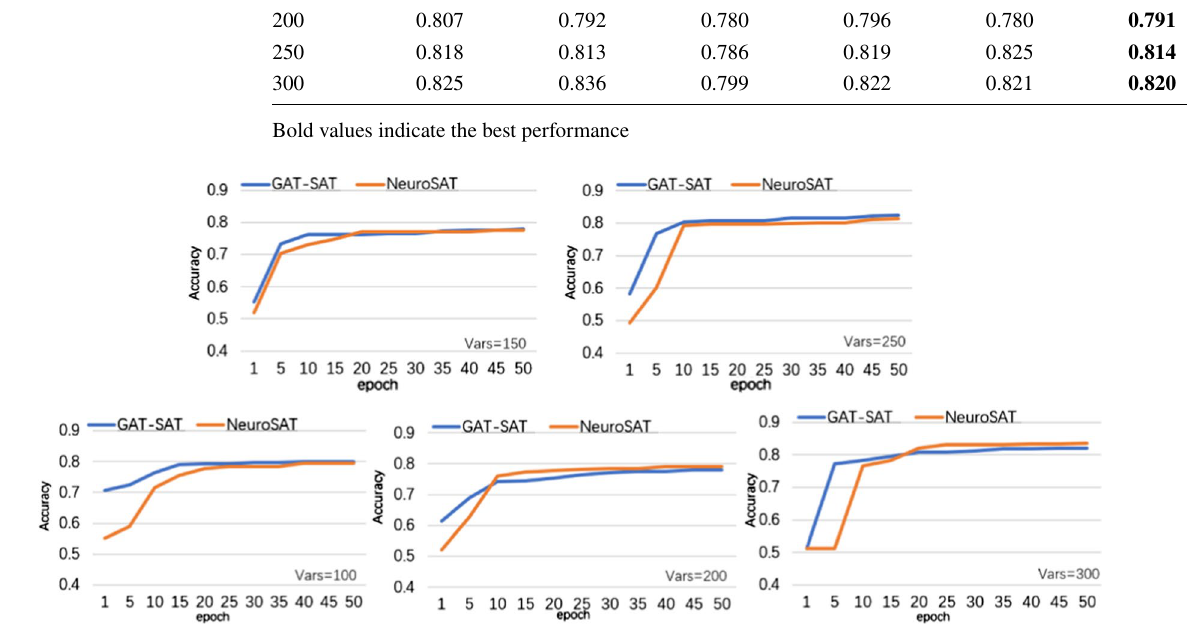
Table 2 Experimental results on the random 3-SAT problem dataset